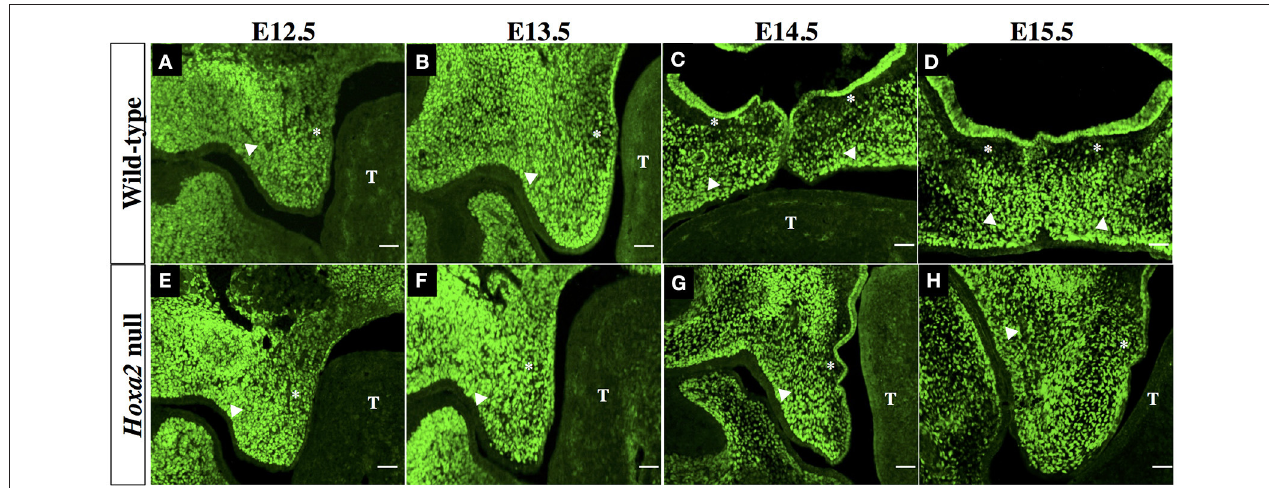
FIGURE 2 | Immunohistochemical (IHC) analysis of Six2 localization in the palatal shelves of wild-type (A–D) and Hoxa2 null embryos (E–H) at developmental stages E12.5 (A,E) , E13.5 (B,F) , E14.5 (C,G) , and E15.5 (D,H) . Photomicrographs are mid-coronal sections, and are representative of a minimum of 5 biological replicates per stage. In each photograph, the asterisk indicates the nasal half of the palatal shelf and the arrow head indicates the oral half of the palatal shelf. T, identifies the developing tongue. Six2 immunostaining in the mesenchyme of wild-type palatal shelves appeared most intense at stages E12.5 (A) and E13.5 (B), and was uniformly distributed throughout the palatal shelf at these early stages. However, by stages E14.5 (C) to E15.5 (D) there was a pronounced decline in Six2 expression by a layer of mesenchyme cells in the nasal half of the palatal shelf lying immediately beneath the palatal epithelium. In Hoxa2 − / − embryos (E–H) , Six2 immunostaining persisted throughout the palatal mesenchyme within the nasal half as well as the oral half of the palatal shelf at all stages from E12.5-15.5 (E–H) . Note that the palatal shelves of Hoxa2 null embryos fail to elevate and remain oriented vertically alongside the tongue (G,H) . Scale bar, 50 µ m.